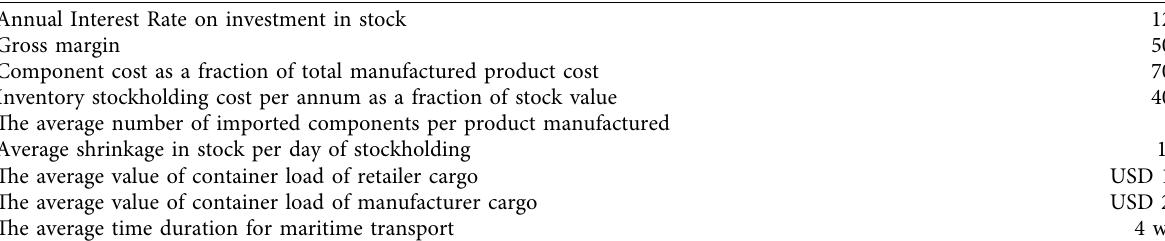
Table 2: Cargo owner costs